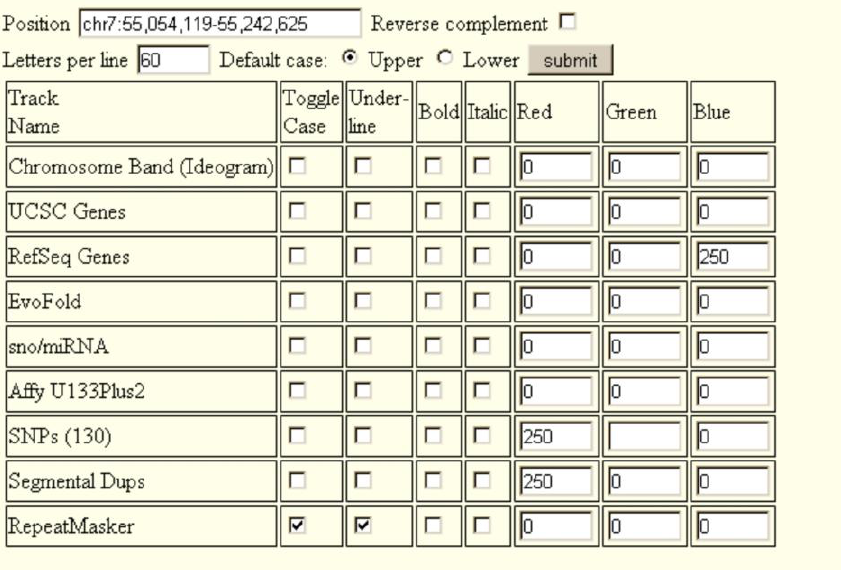
sections: a 5’ half-probe (yellow panels) and a 3’ half-probe (green panels). Each